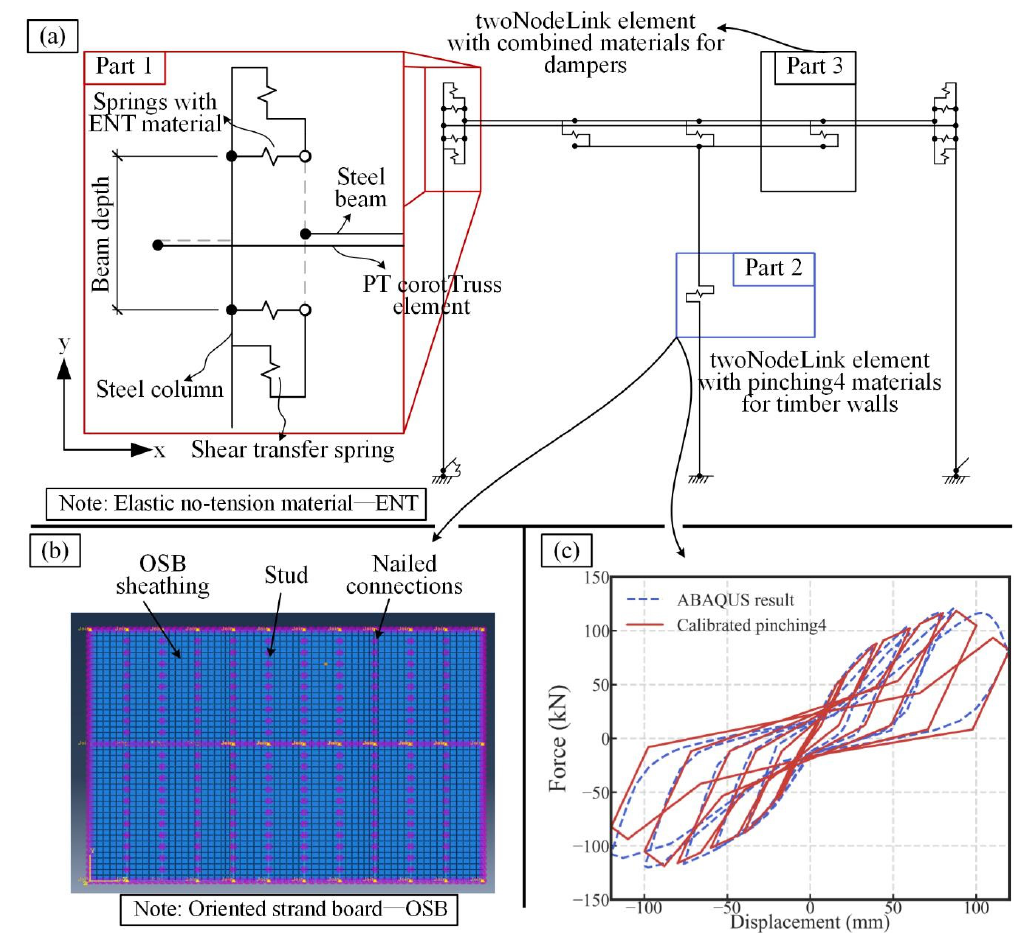
Figure 8. ( a ) Numerical model; ( b ) the detailed ABAQUS model for the light frame wood shear wall; ( c ) the calibration of the pinching4